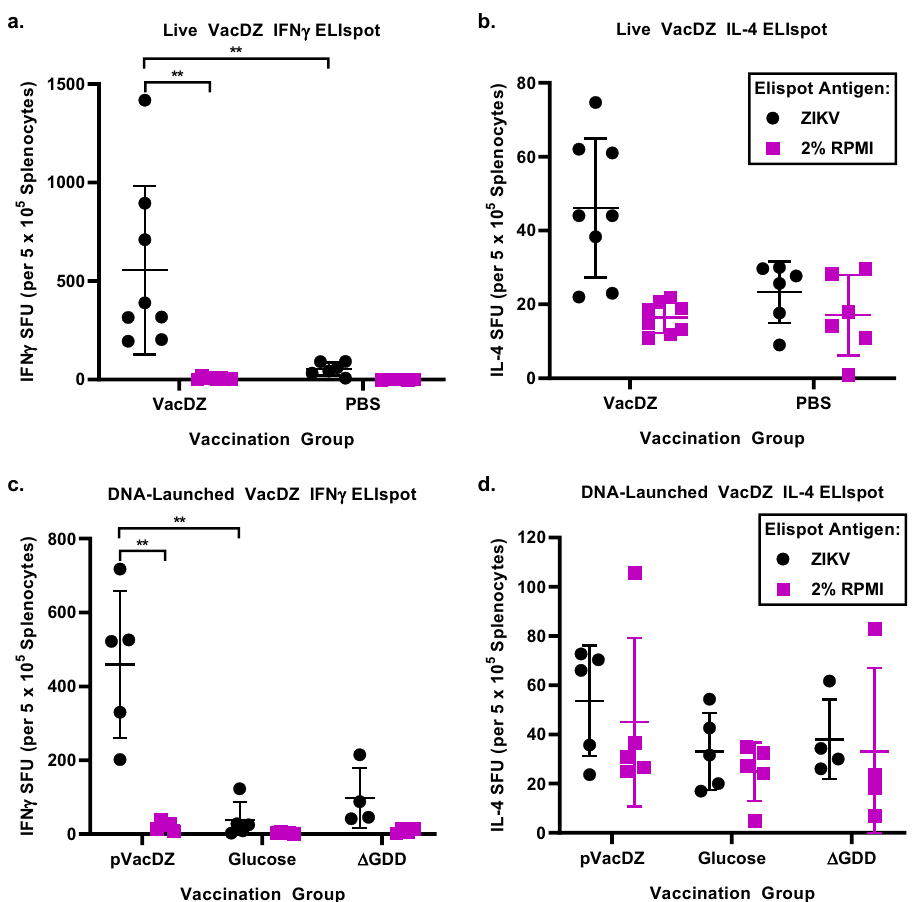
Fig. 5 ELIspot assay of T helper cell response. 5-8 weeks old AG129 mice were inoculated intraperitoneally with the indicated vaccine or control and then boosted four weeks later with the same dose of their respective vaccine or control. Four weeks after boosting the mouse splenocytes were harvested. IFN γ -ELIspot was used to analyse the Th1 response, and IL-4-ELIspot was used to analyse the Th2 response. Each point represents one mouse and is the mean spot forming unit (SFU) count of three technical replicates. Magenta circles: activated with ZIKV, black squares: activated with RPMI medium control. a , b IFN γ and IL-4 ELIspot assays respectively for AG129 mice vaccinated with live VacDZ (10,000 PFU per mouse, n = 8) or PBS vehicle control ( n = 6). c , d IFN γ and IL-4 ELIspot assays respectively for AG129 mice vaccinated with DNA-launched VacDZ (pVacDZ, 80 μ g of pVacDZ and 20 μ g of pTet-Off Advanced per mouse, n = 5), 5% glucose solution vehicle control (glucose, n = 5), or pVacDZ- Δ GDD replication defective mutant ( Δ GDD, 80 μ g of pVacDZ- Δ GDD and 20 μ g of pTet-Off Advanced per mouse, n = 4). Statistical analysis was performed using one way ANOVA, and post-hoc analysis was performed using Tukey HSD. Statistical signi fi cance: *, P < 0.05; **, P < 0.01; ***, P <